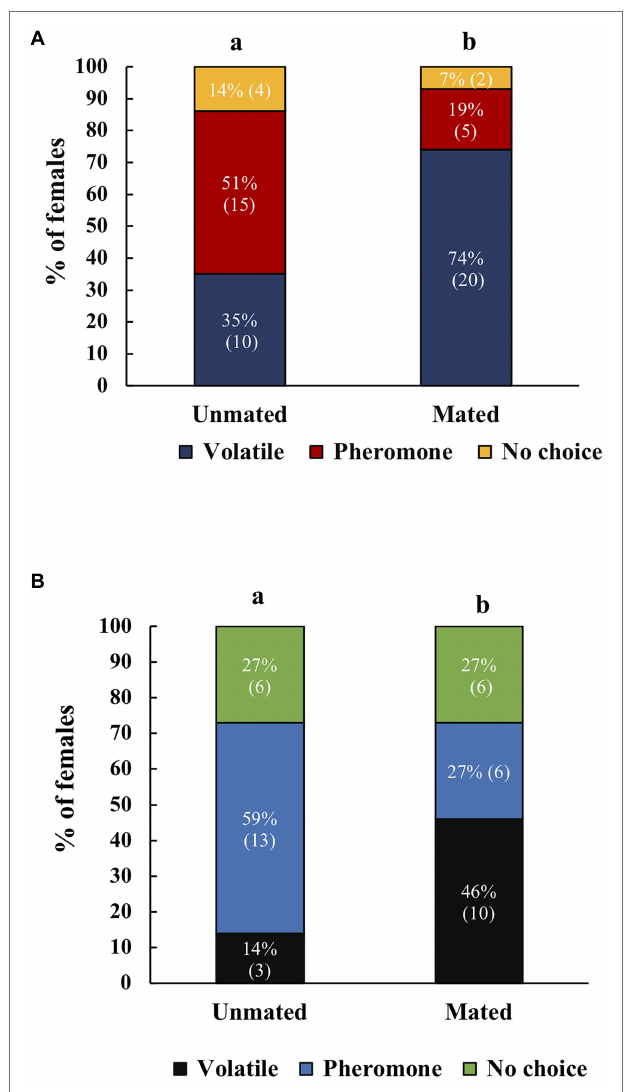
FIGURE 4 | (A) Response of unmated or mated A. ludens females to host volatiles or male sex pheromone, ( N = 29 for unmated, N = 27 for mated). (B) Response of unmated or mated A. obliqua females to host volatiles or male sex pheromone, ( N = 22 for unmated, N = 22 for mated). The y -axis represents the percentage of all females that were tested. Different letters indicate significant differences at the 0.05 level between treatments. Numbers within parenthesis represent sample size.